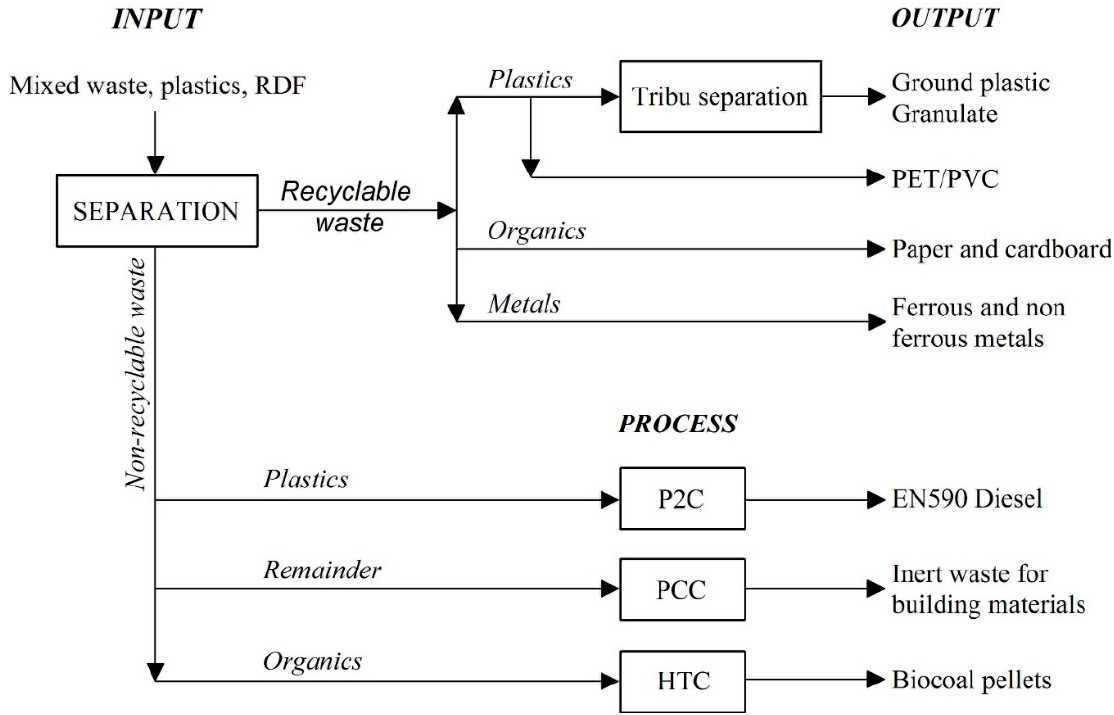
Figure 3. Flowchart of Renasci Smart Chain Processing in Ostend [26].